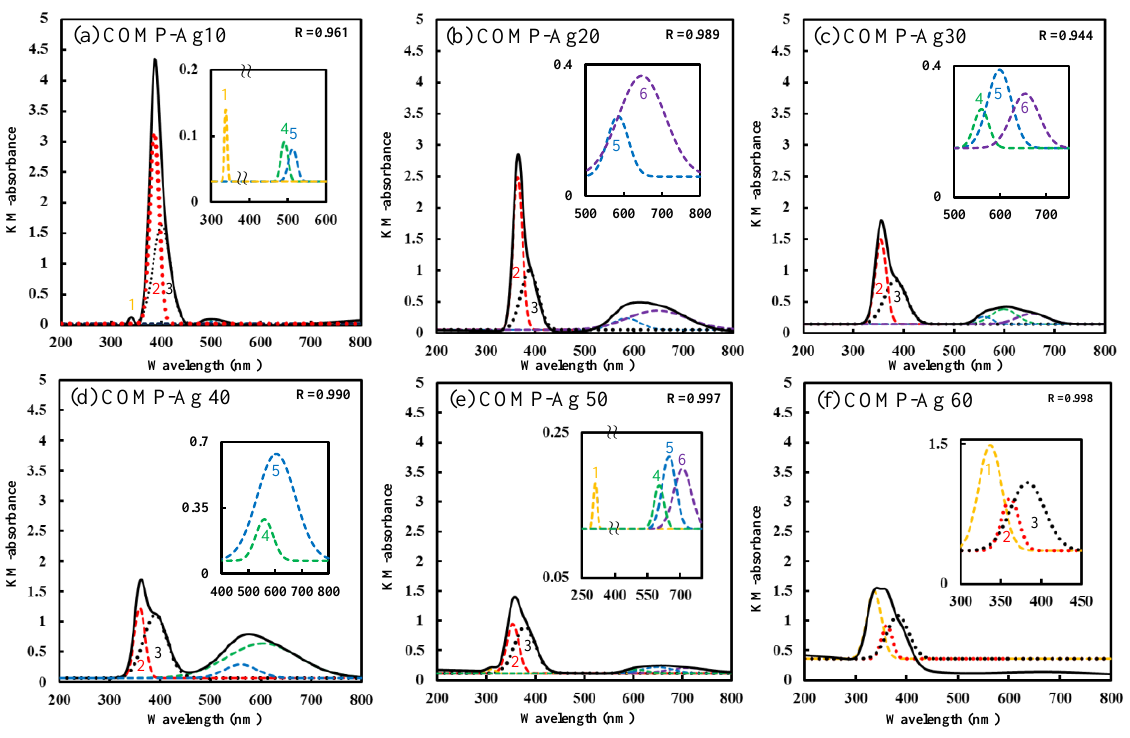
Figure 6. UV–Vis diffuse reflectance spectra (DRS) of Ag-NP/TiO at various amounts of Ag molar concentrations: ( a ) 10; ( b ) 20; ( c ) 30; ( d ) 40; ( e ) 50; ( f ) 60; ( g ) 70 and ( h ) 80, respectively.